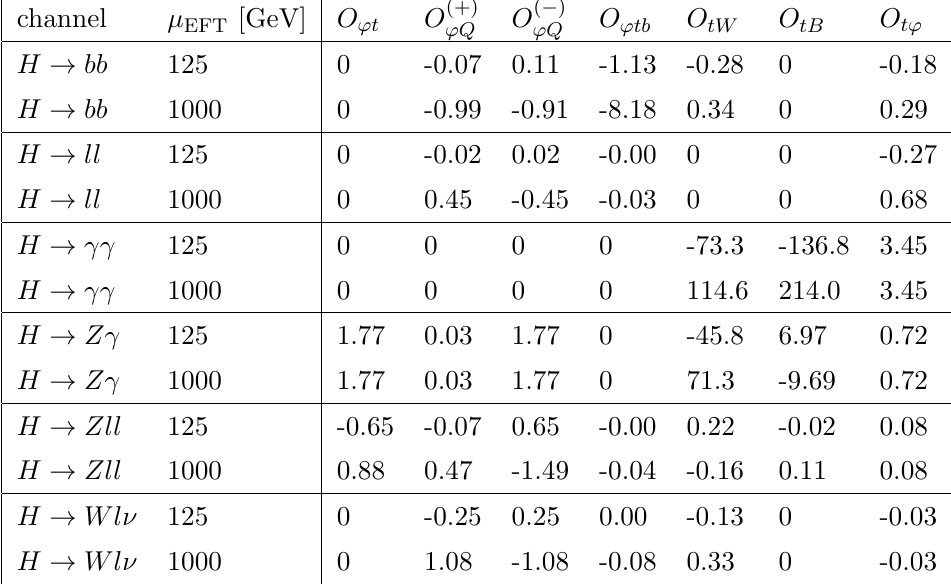
Table 14 . Percentage deviation (cid:22) ij for decay channel i and operator j , in the MS scheme.